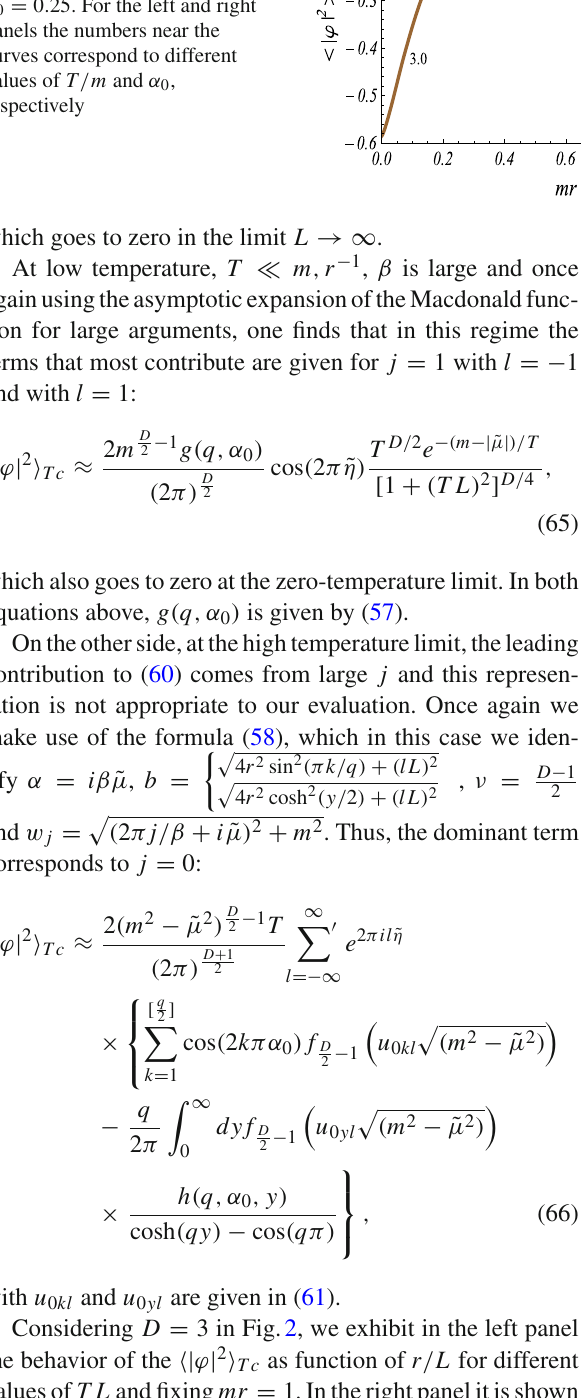
Fig. 1 The thermal field squared induced by the string is plotted for D = 3 as functions of the product mr and the ratio T / m , with fixed parameters q = 2 . 5, | ˜ μ | / m = 0 . 5 and α = 0 . 25. For the left and right 0 panels the numbers near the curves correspond to different values of T / m and α 0 , respectively